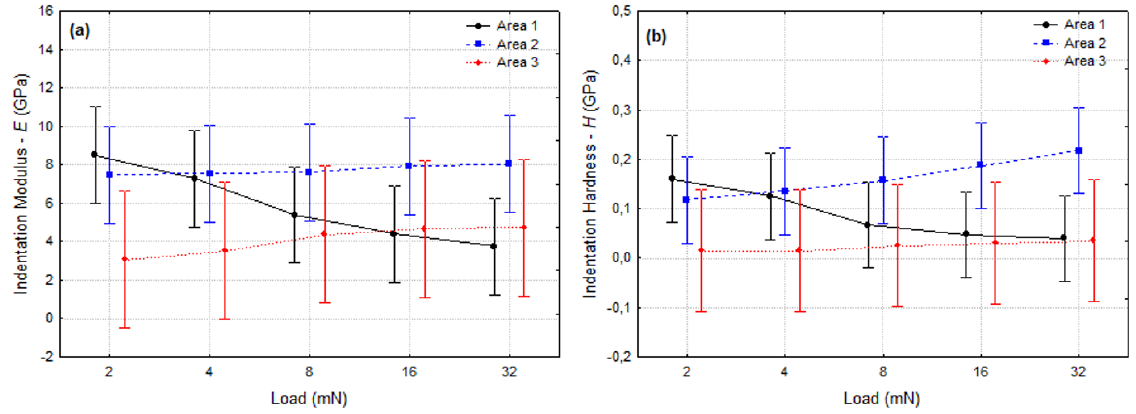
Figure 4. Micro-nanomechanical properties (elastic modulus and hardness) of C-S-H/PMA in specific areas.